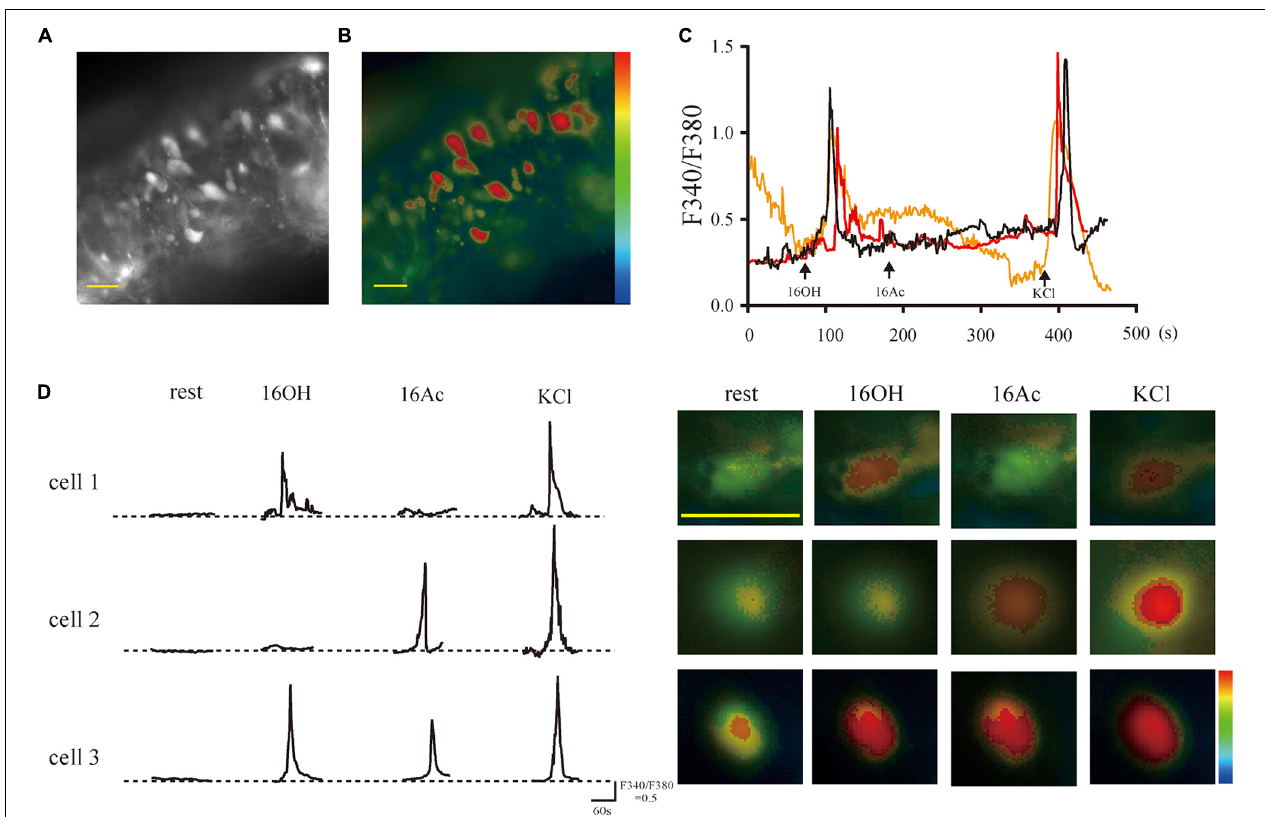
FIGURE 1 | The pheromones evoke responses of intracellular Ca 2 + elevation from single vomeronasal sensory neurons. (A,B) Fluorescence images on gray and pseudocolor scales, respectively, acquired from a VNO slice loaded with fura-2-AM. The somata of the VSNs contained most of the calcium-sensitive dye. (C) Traces of three VSNs responsive to 100 µ M 16OH and KCl (50 mM) but not to 100 µ M 16Ac over a period of 8 min. (D) Left: Response profiles of three representative VSNs: cell 1 responded to 16OH alone, cell 2 to 16Ac alone, and cell 3 to both; Right: the corresponding Fura-2 ratio images of the three VSNs. KCl (50 mM) was used as a positive control. Scale bar: 20 µ m.